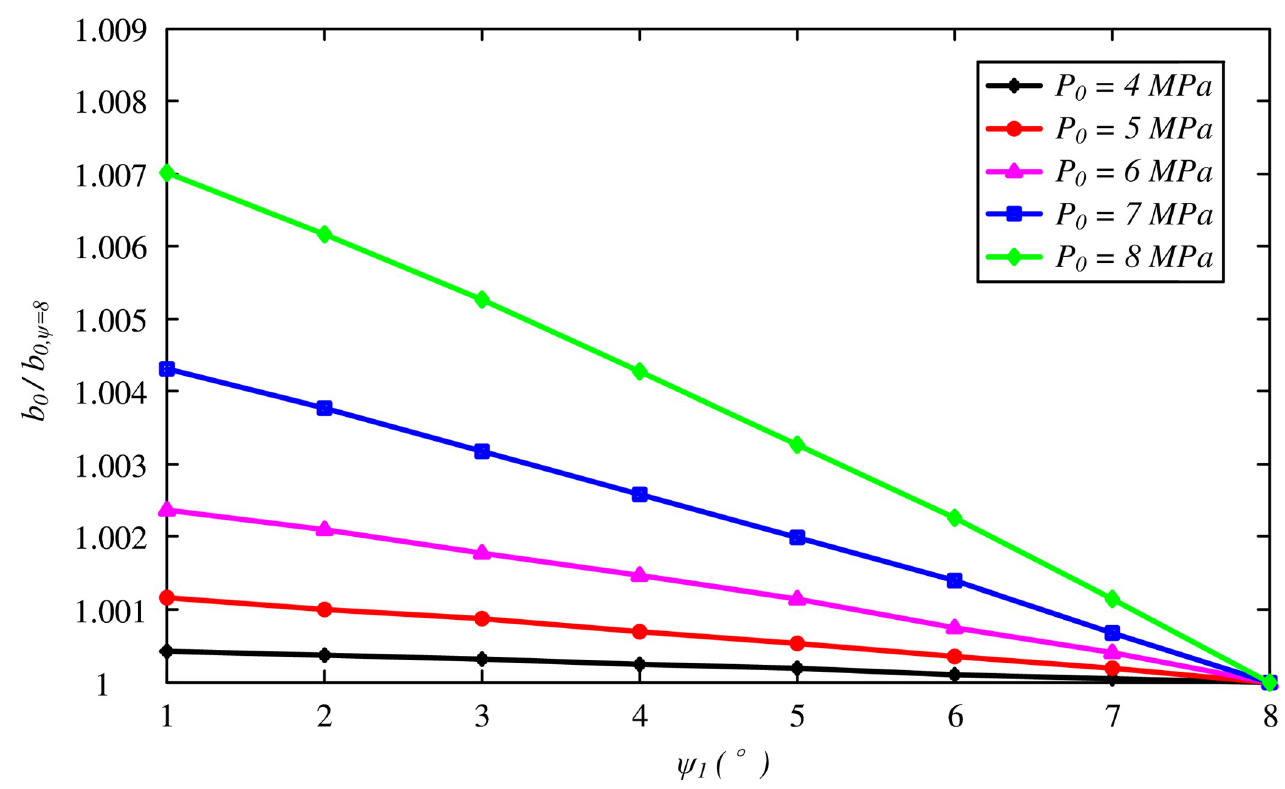
Fig 6. Variation of optimal thickness of the FSW with dilation angle ψ 1